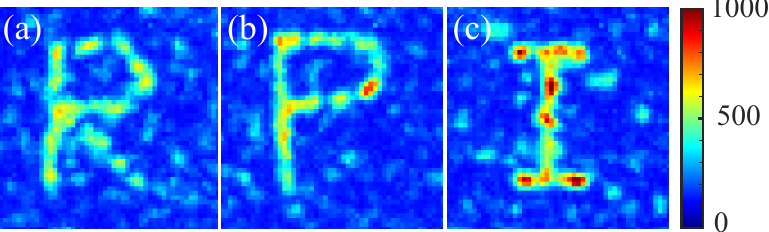
Figure 10. Patterns “R” ( a ), “P” ( b ), and “I” ( c ) were created experimentally by utilizing SBGA with three discriminants ( f 1 , f 2 , f 3 ) and ranking coefficient ( a , b , c ) = ( 2,1,0.5 ) .